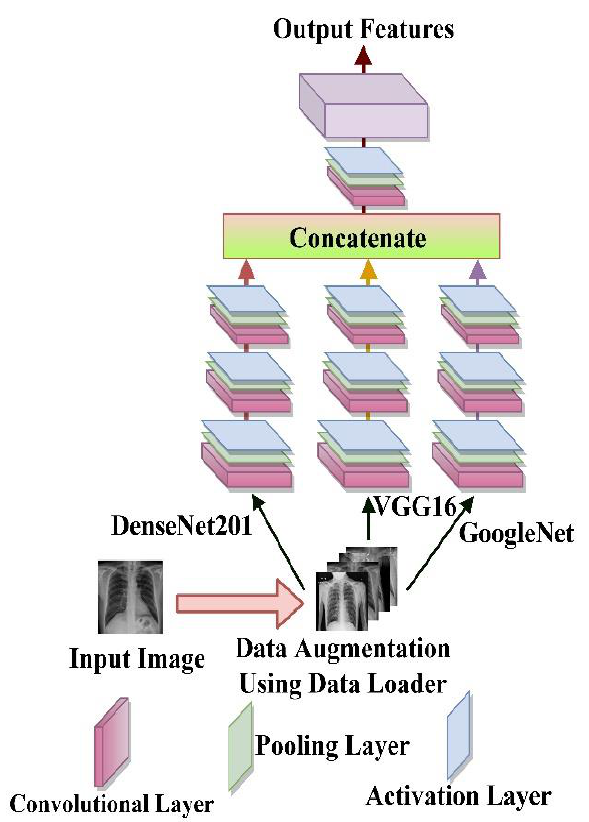
Figure 4. Mode of Feature extraction of the proposed study. From the network backbone up to the global second-order pooling layer.